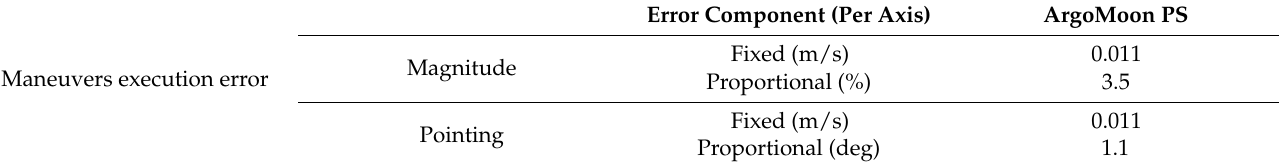
Table 3. Gates model assumptions for the maneuvers execution error (1 σ ).